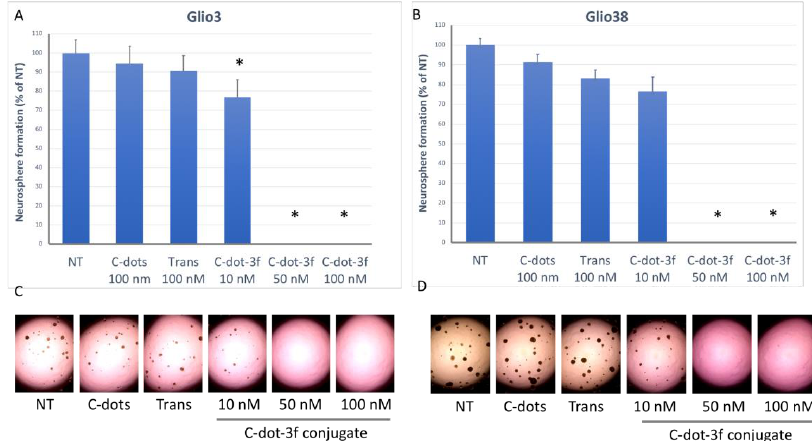
Figure 10. Effect of C-dot-3f conjugate treatment on GSC neurosphere formation. GSCs were dissociated and single cells plated in 96 well plates (approximately 50 cells/well) and treated with 100 nM C-dots alone, 100 nM Transferrin (Trans) or the C-dot-3f conjugate at concentrations shown. Fourteen days later, the number of neurospheres greater than 100 microns was determined for Glio3 ( A ) and Glio38 ( B ). * p < 0.05 compared to non-treated controls. Representative images for Glio3 ( C ) and Glio38 ( D ).